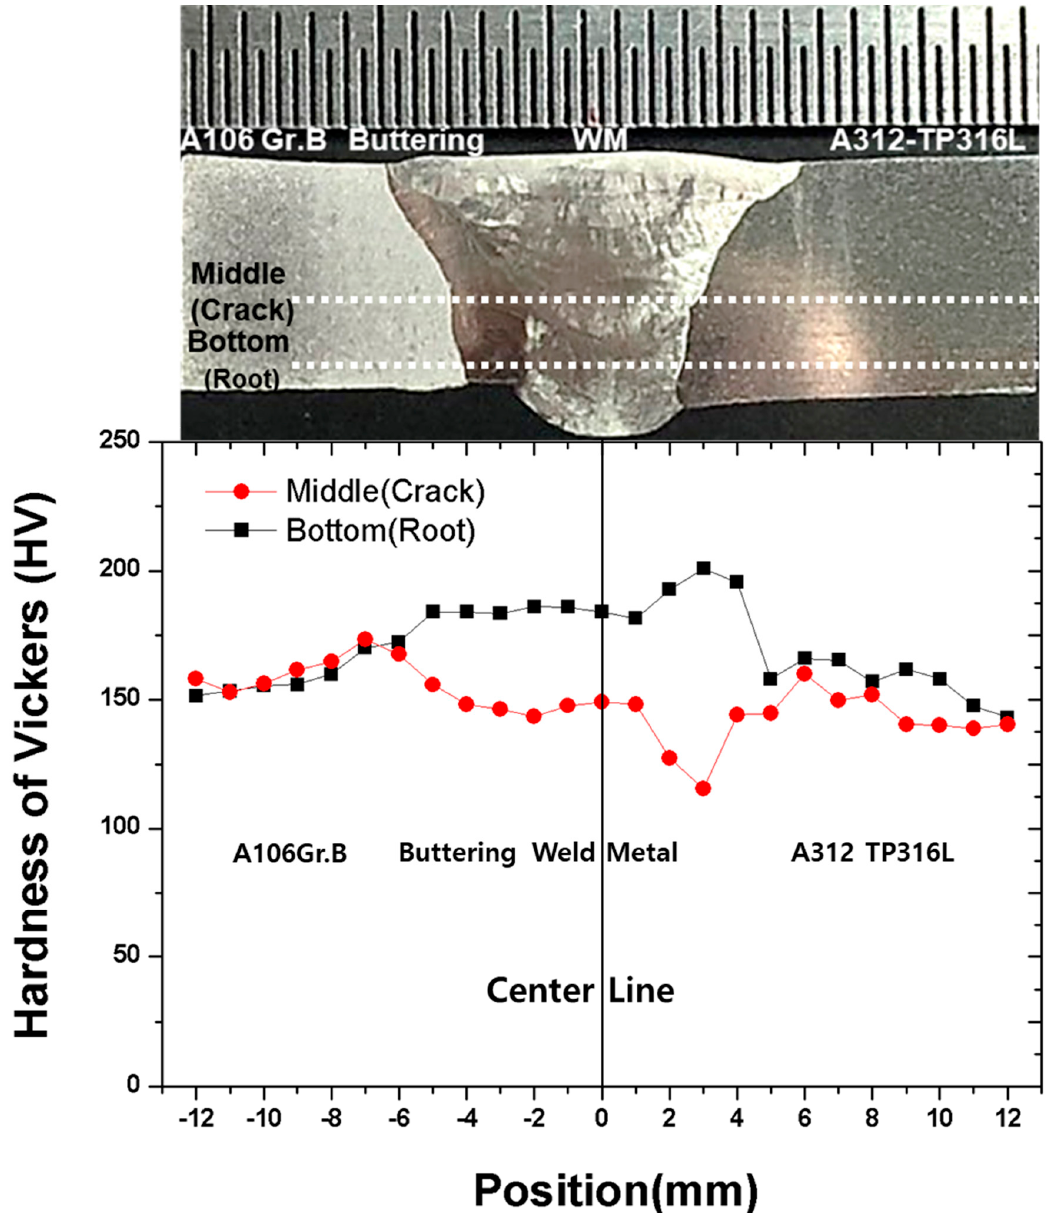
Figure 9. Vickers hardness in the weldment.